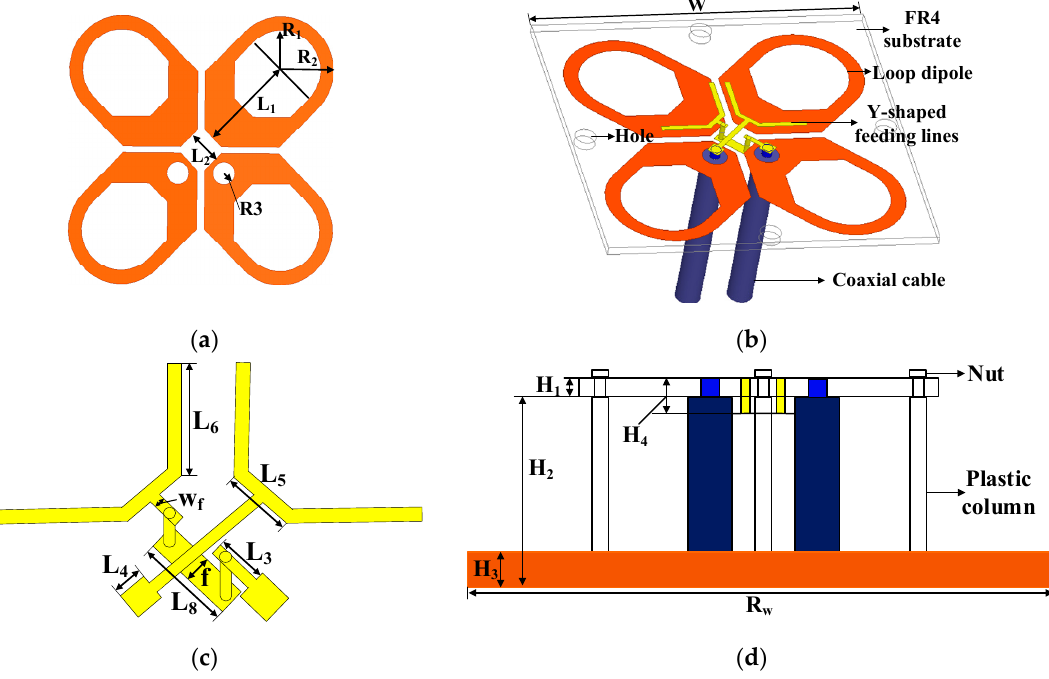
Figure 1. Geometry of the proposed antenna. ( a ) Top view of the radiator, ( b ) 3D view of the antenna, ( c ) perspective view of the feeding lines, and ( d ) side view of the antenna.